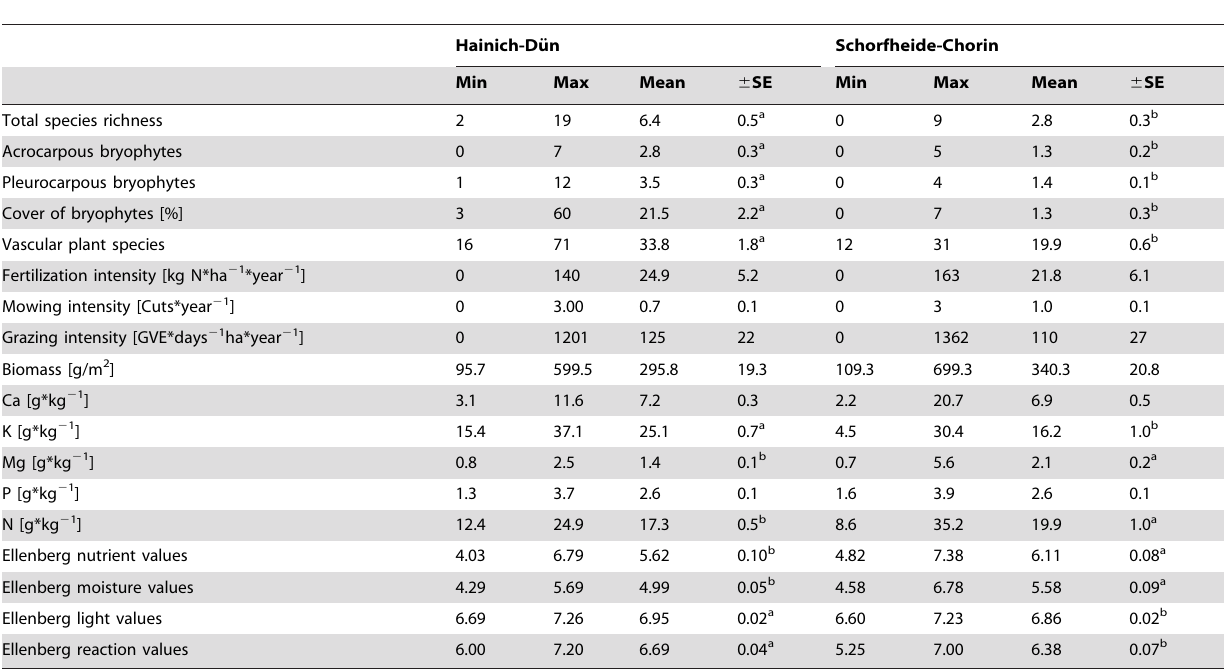
Mean, minimum, maximum and SE of bryophyte diversity, vascular plant species, land-use measures, aboveground vascular plant biomass, nutrient content of biomass (Ca=calcium, K=potassium; Mg=magnesium, P=phosphorus; N=nitrogen), and mean Ellenberg indicator values for vascular plants for the two regions. Letters ( a, b ) indicate significant group differences between the regions.